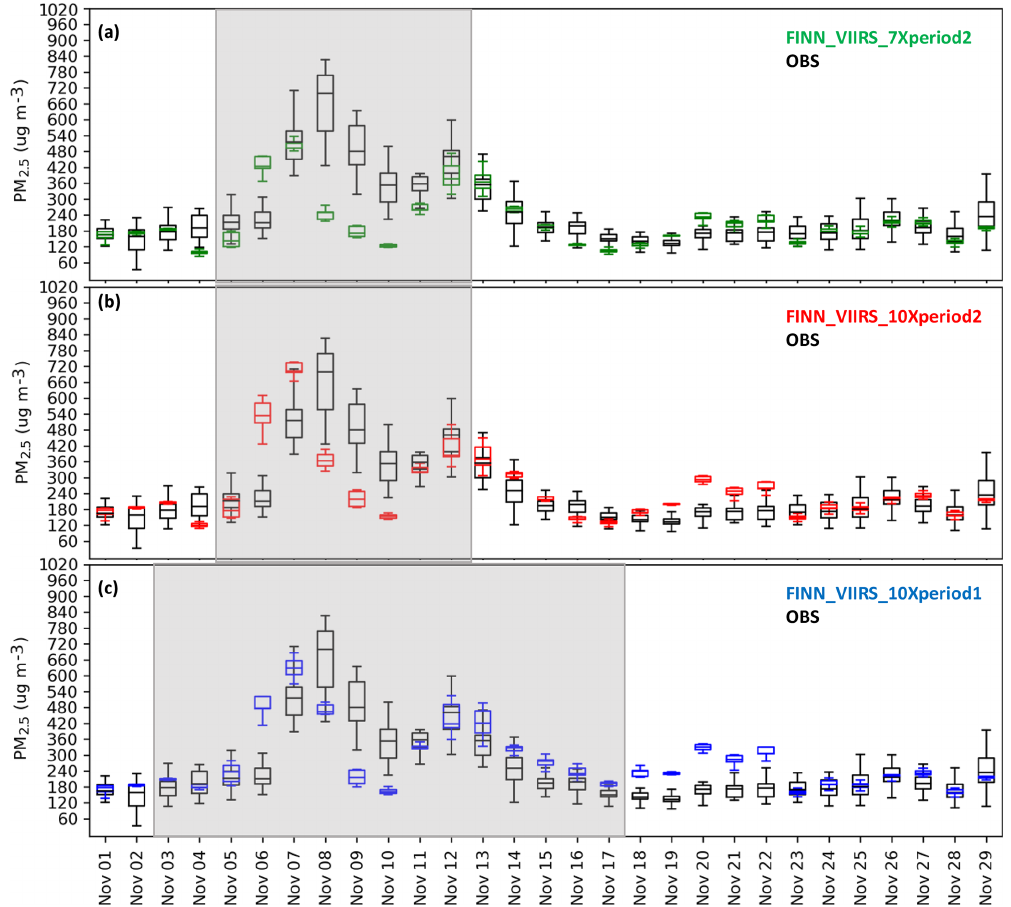
Figure 6. Box-and-whisker plots of observed (black) and modeled daily PM 2 . 5 concentration averaged over all CPCB stations in Delhi: (a) FINN_VIIRS_7Xperiod2, (b) FINN_VIIRS_10Xperiod2, and (c) FINN_ VIIRS_10Xperiod1. Shaded area shows the time window when biomass burning emissions were